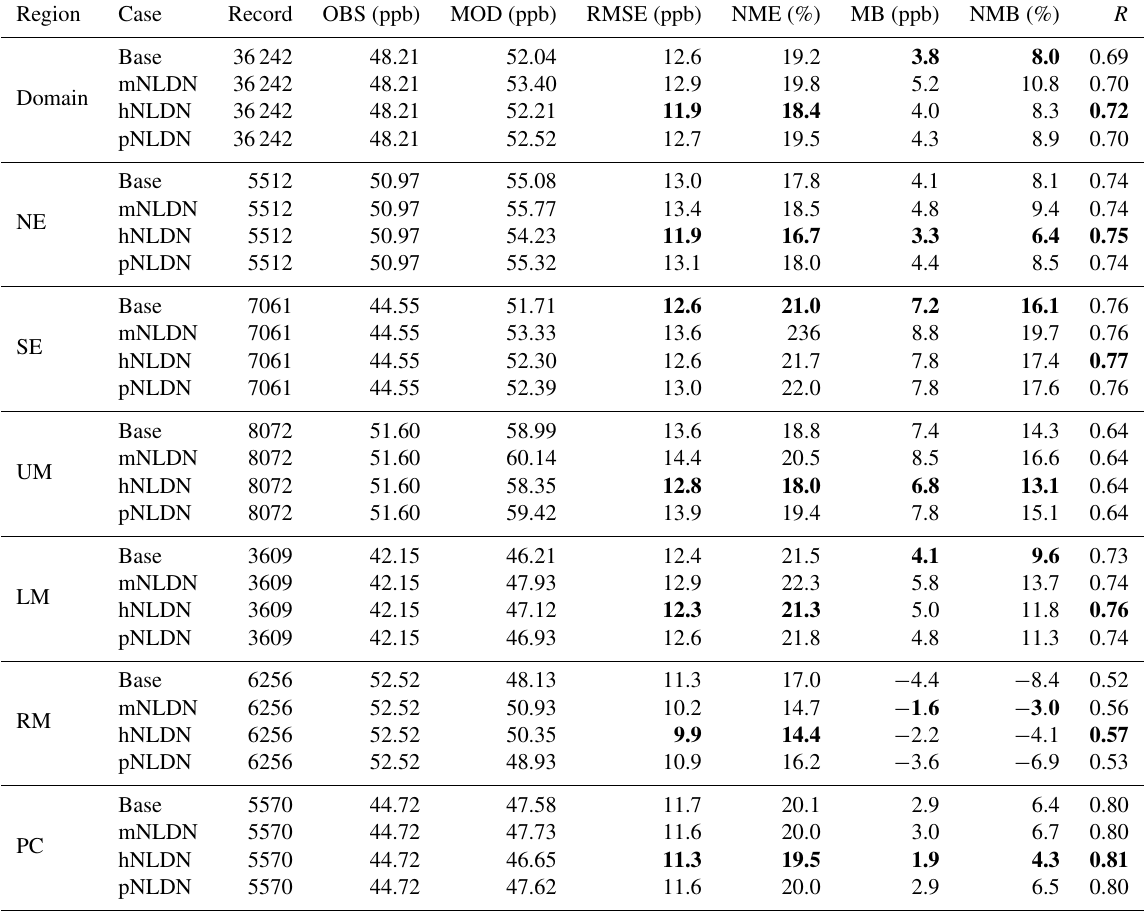
Table 1. Statistics of DM8HR O 3 for all model cases over the domain and analysis regions in July 2011. The best performance metrics among the model cases are highlighted in